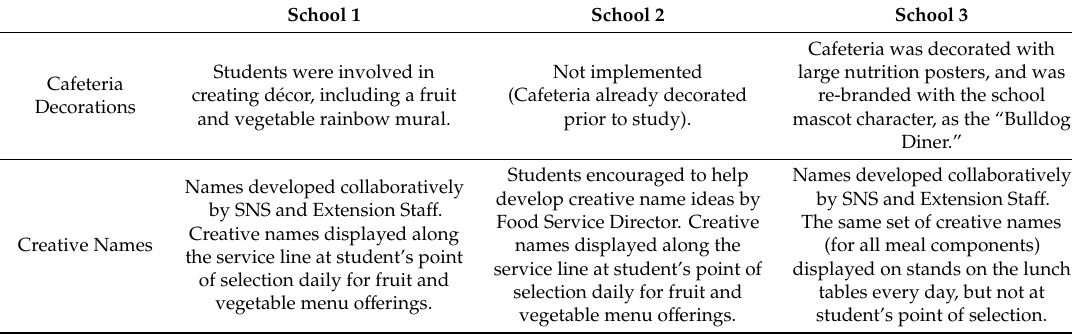
Table 2. Variation in intervention process and implementation between all three